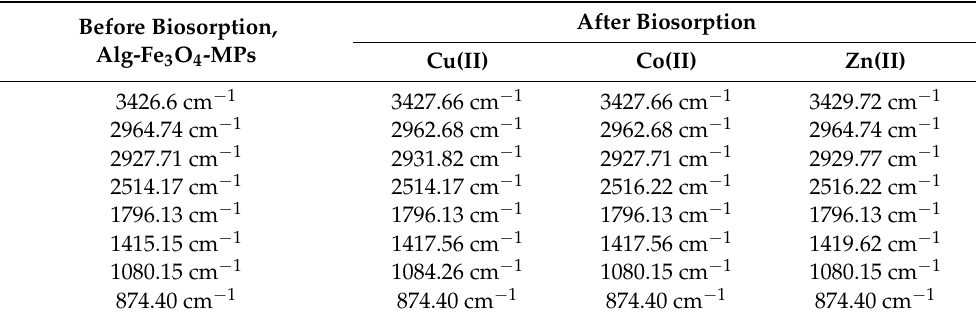
Figure 7. FTIR spectra of Alg-Fe 3 O 4 -MPs before (1) and after biosorption of Cu(II) (2), Co(II) (3) and Zn(II) (4) ions from aqueous media. Table 5. Variation of the maximum wave numbers of the characteristic peaks in the FTIR spectra of Alg-Fe 3 O 4 -MPs before and after biosorption of metal